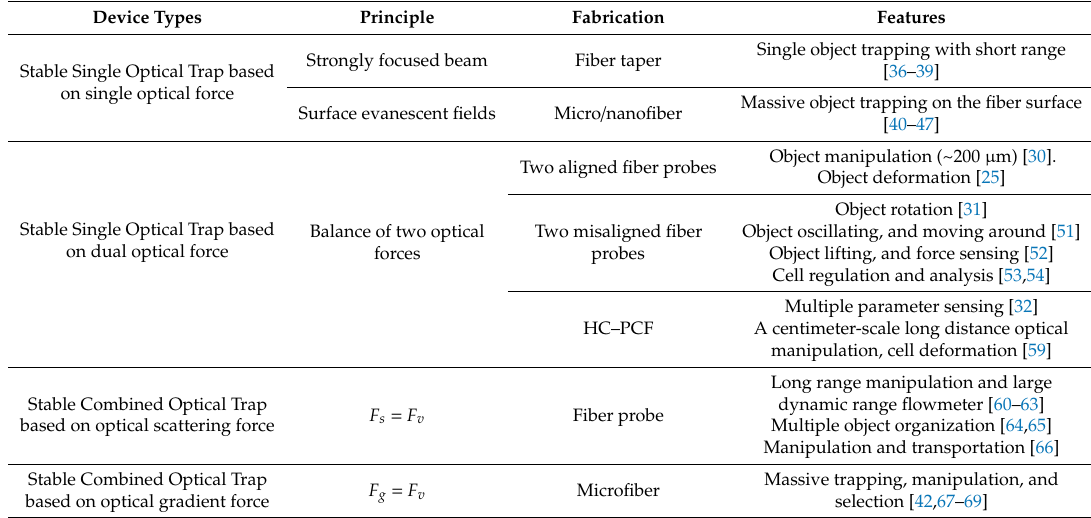
Table 2. A summary of fiber optofluidic technology based on optical